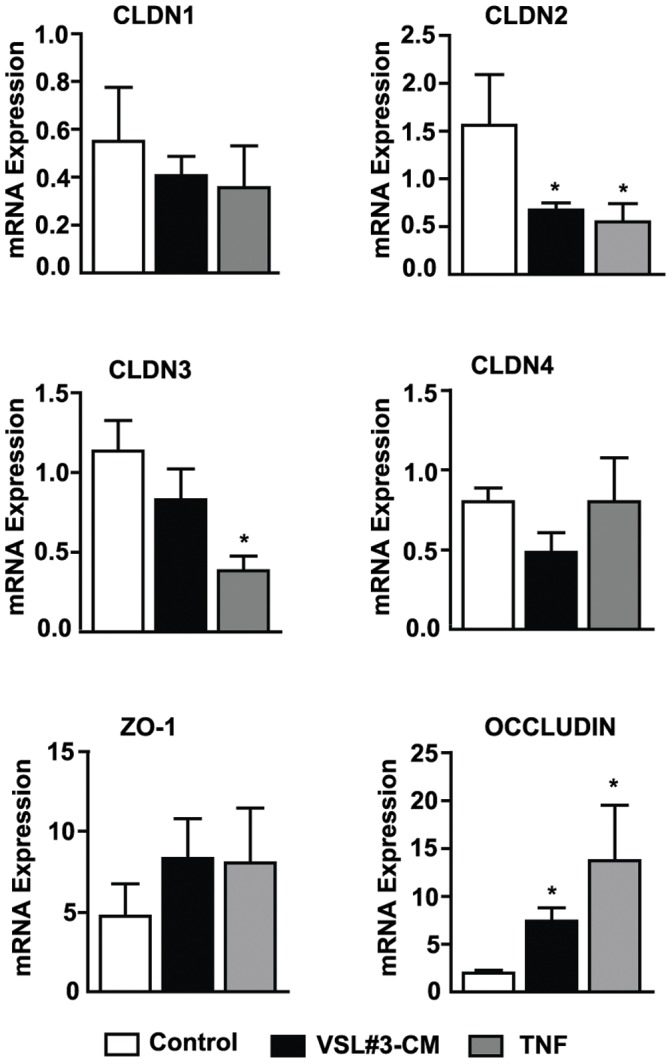
VSL#3 and TNF modulate TJ protein expression in ilea from pre-inflamed SAMP mice.mRNA transcript levels of TJ proteins (claudins 1–4, ZO-1, and occludin) were measured by qRT-PCR and expressed relative to ß-actin in full-thickness ilea from experimental mice following ex vivo culture with either VSL#3-CM or TNF. The greatest differences in expression were seen in claudin-2 (decrease) and occludin (increase) after either VSL#3-CM or TNF stimulation, and in claudin-3 (decrease) after TNF stimulation only. No differences in expression were noted for claudins 1, 4, and ZO-1 following exposure to either VSL#3-CM or TNF. *p<0.05 vs. vehicle cont. Results are representative of two independent experiments (N = 6/exp group) and expressed as mean ± SEM.